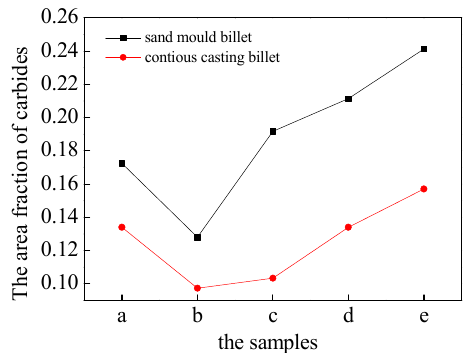
ff erent samples of the M2 steel billets.